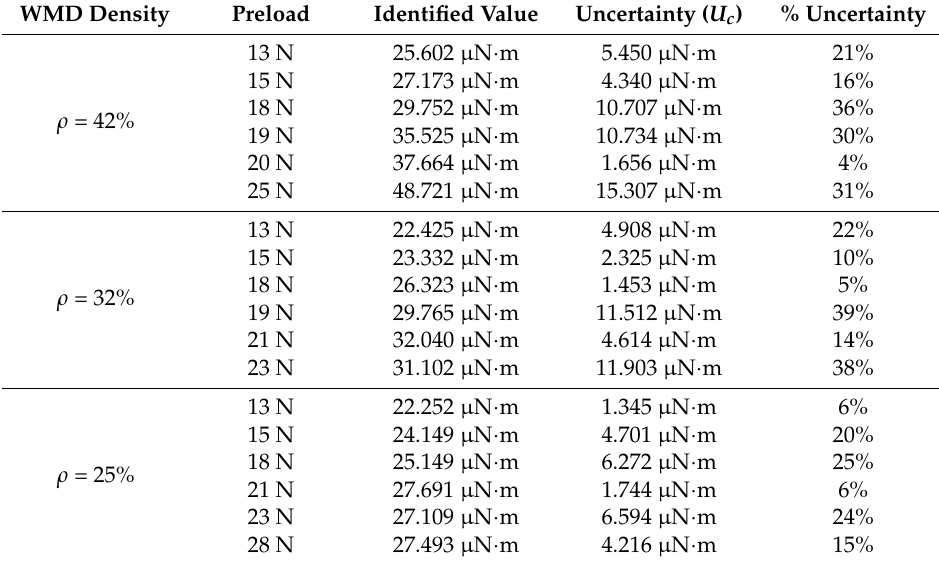
Table A2. Combined standard uncertainty of WMD dissipated energy ( E dis ) in Figure 11.